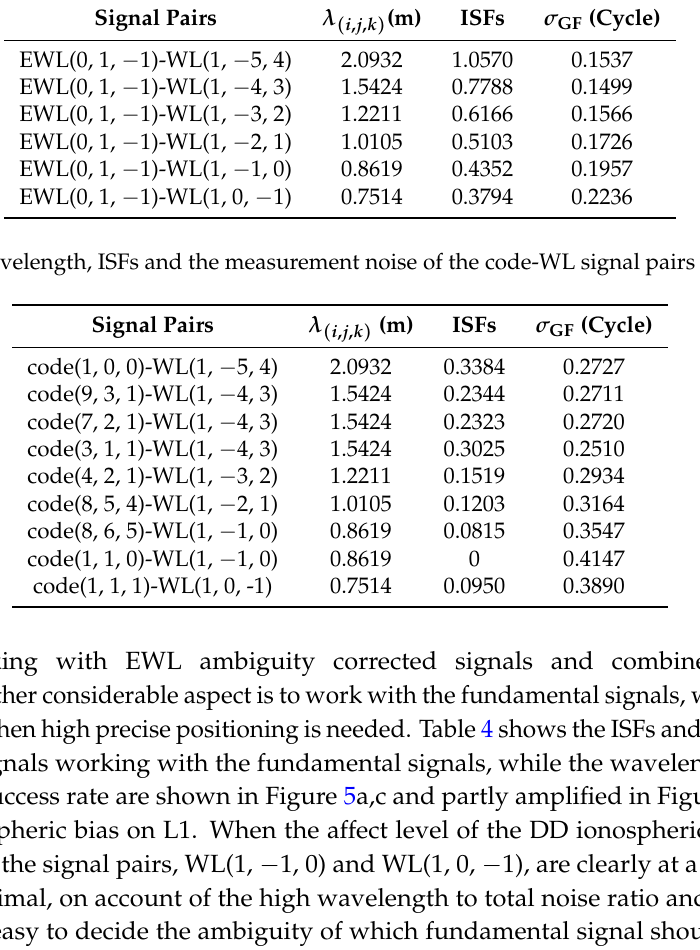
Table 2. The wavelength, ISFs and the measurement noise of the EWL-WL signal pairs for GF TCAR. Signal Pairs